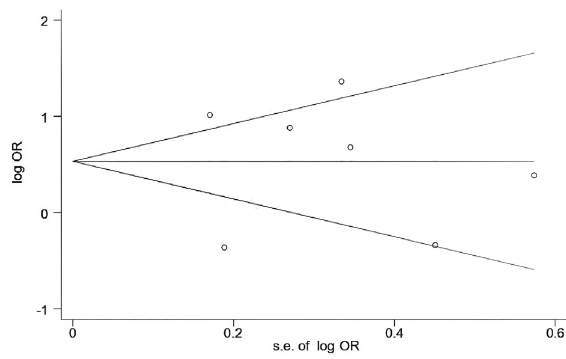
Figure 7. Begg ’ s funnel plot with pseudo 95% con fi dence limits for publication bias